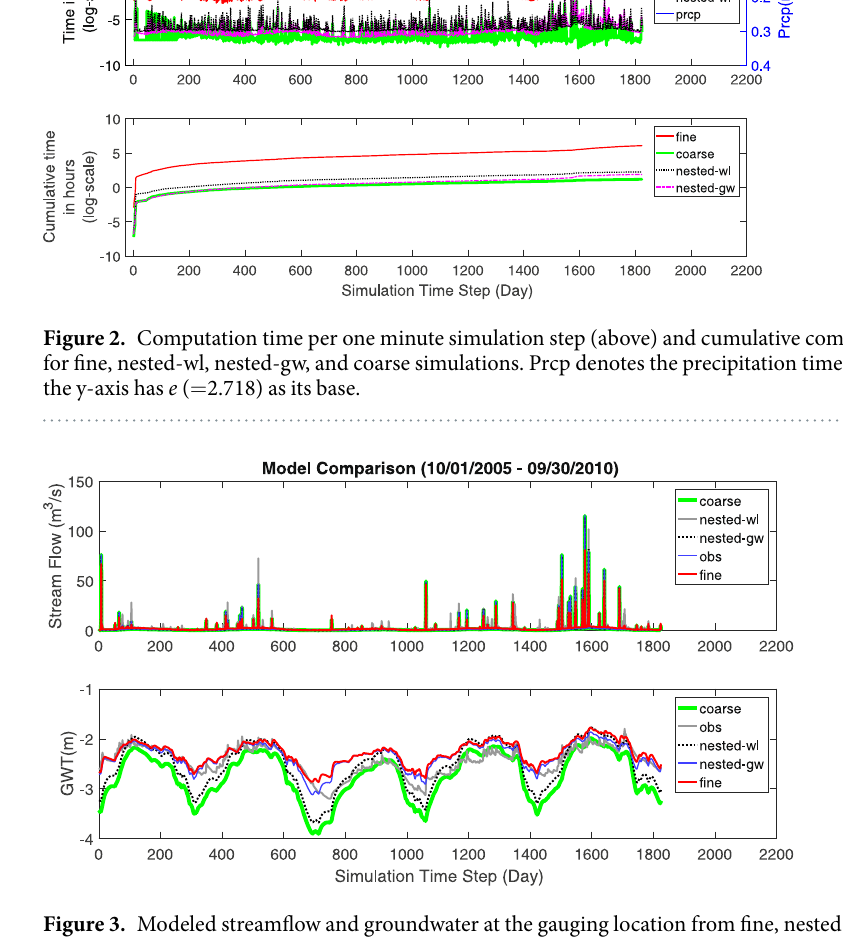
Figure 3. Modeled streamflow and groundwater at the gauging location from fine, nested-wl, nested-gw, and coarse simulations. Semi-log version of the hydrograph plot (top) is shown in Supplementary Fig.